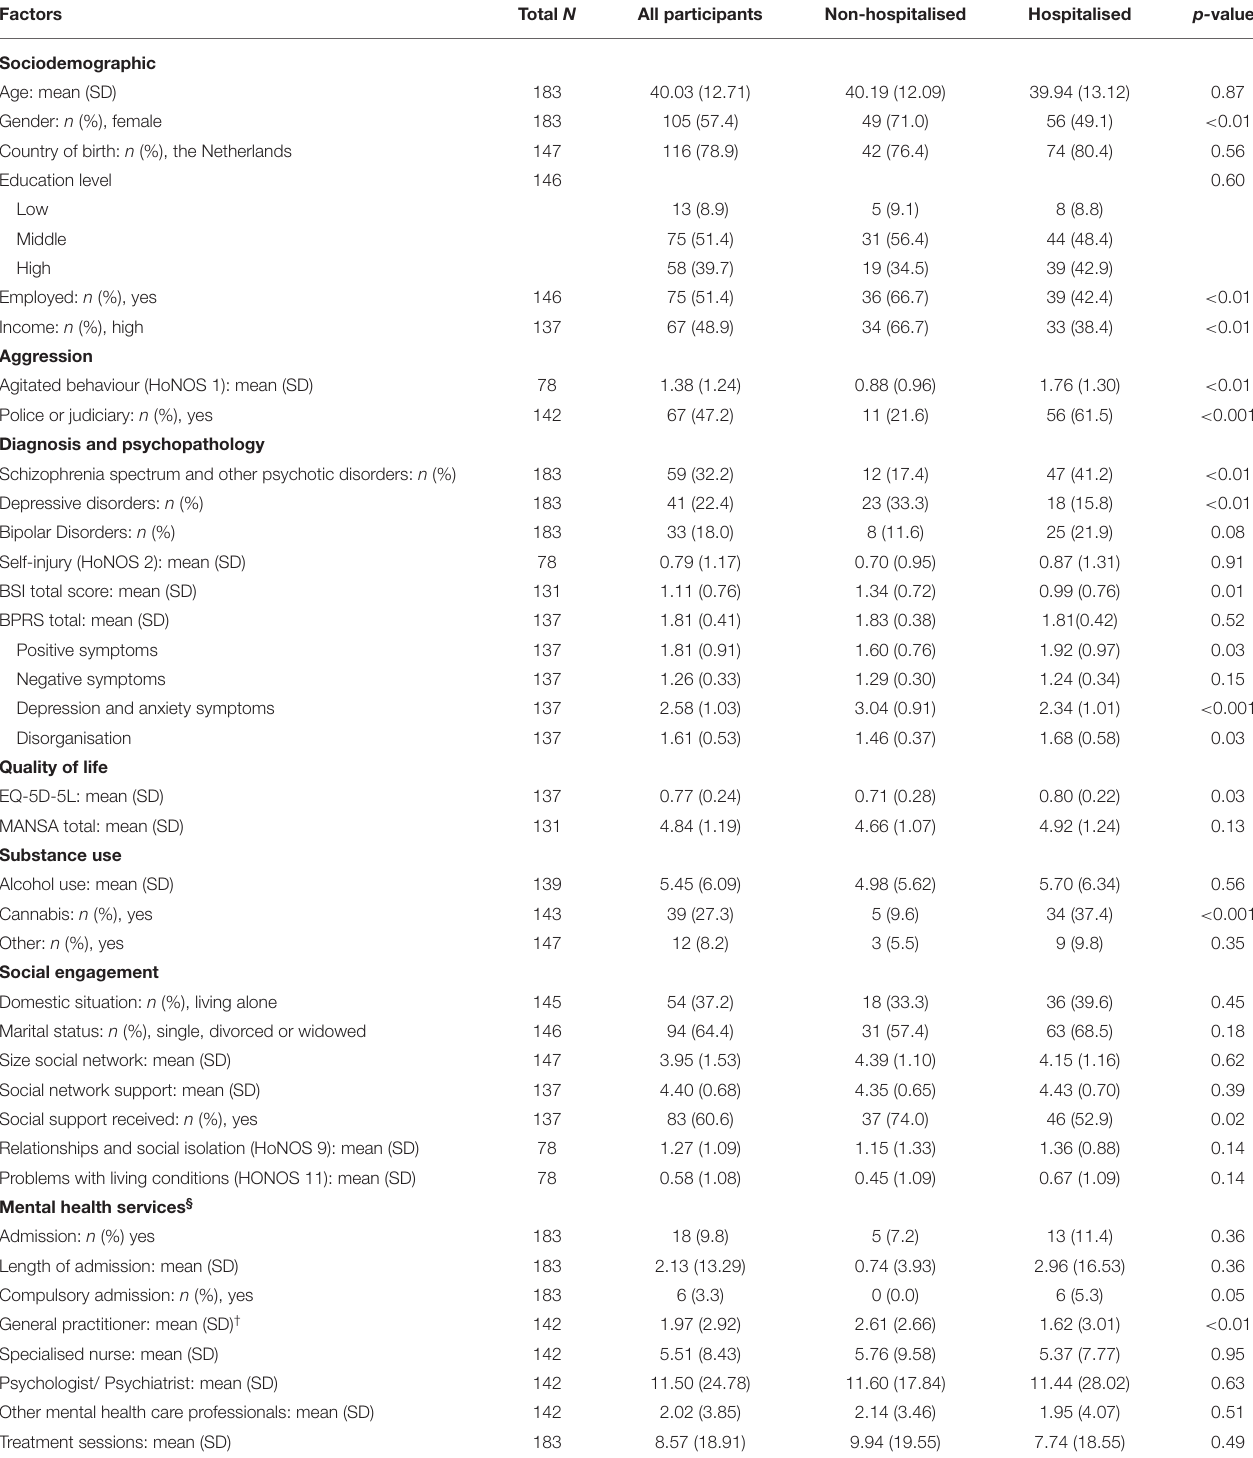
TABLE 1 | Characteristics of the Intensive home treatment cohort, comparison between non-hospitalised and hospitalised group. Factors Total N All participants Non-hospitalised